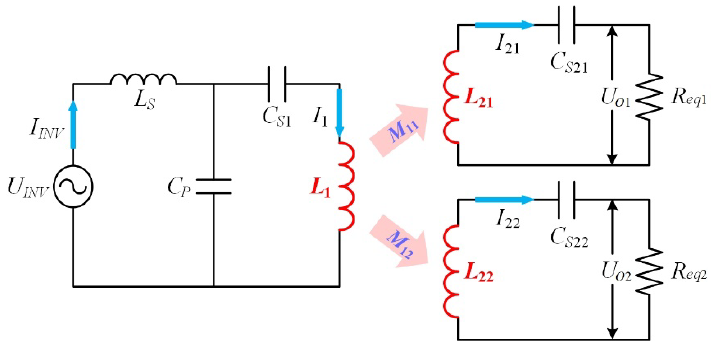
Figure 4. Equivalent mutual-inductance model of LCC-S topology.